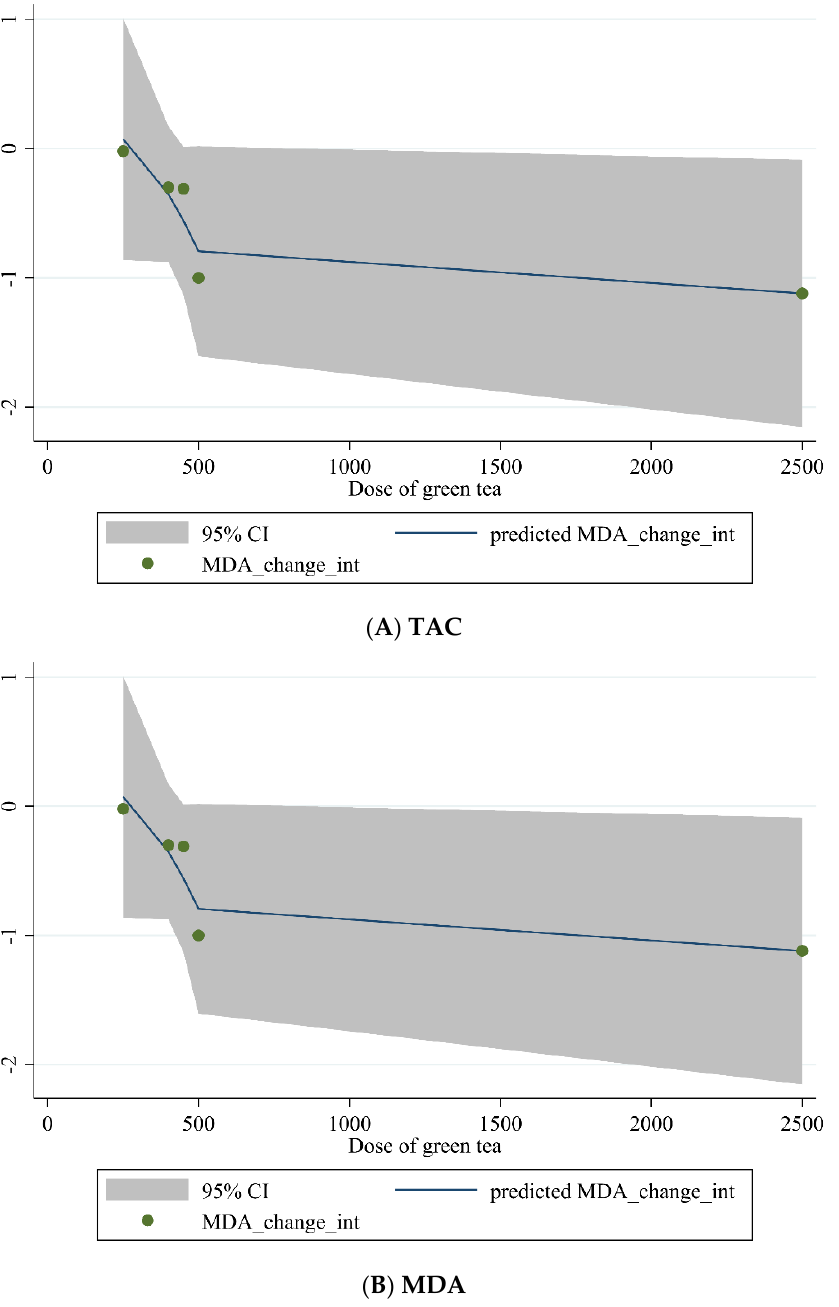
Figure 4. Non-linear dose-response relations between dose of green tea (mg/day) and predicted changes in ( A ) TAC and ( B ) MDA.